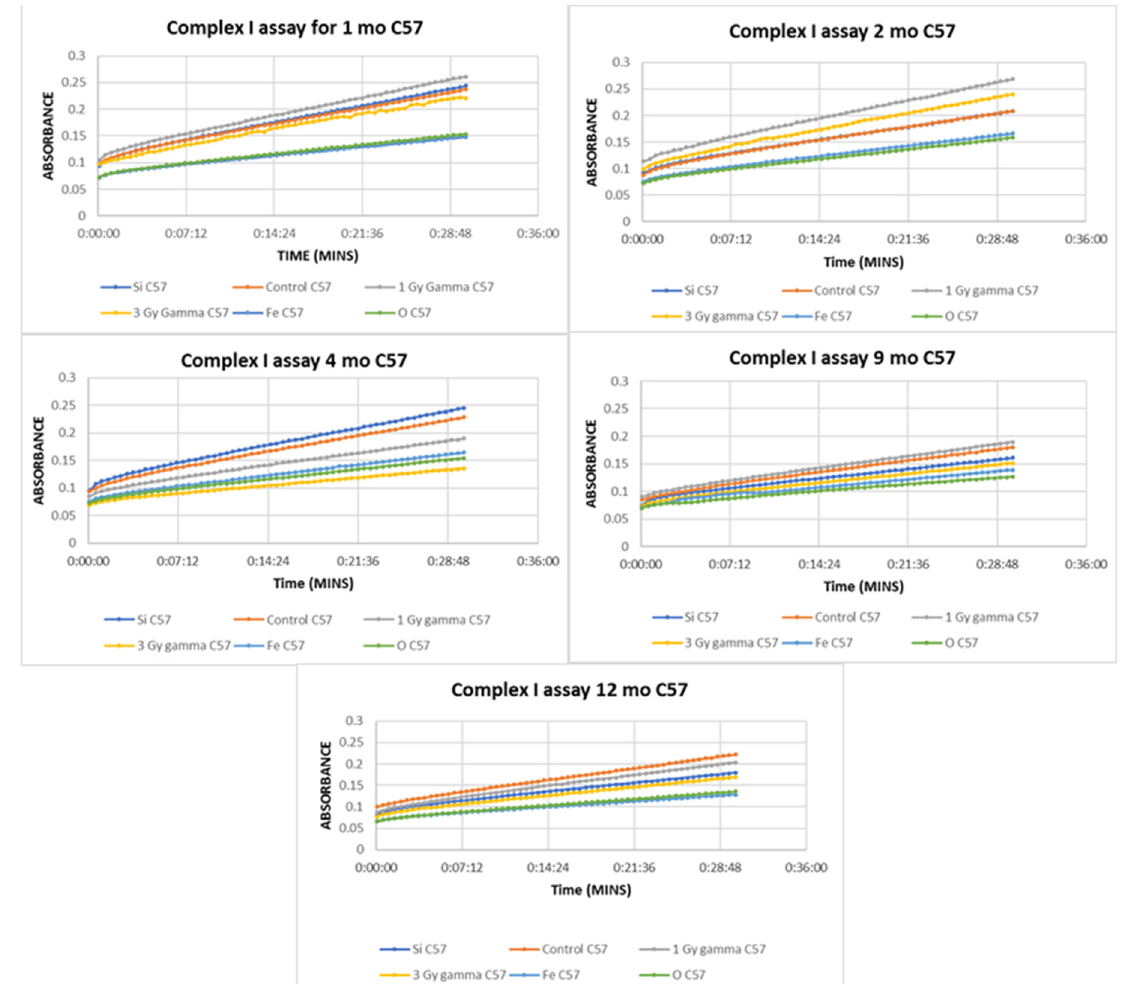
Figure 3. Mitochondrial Complex I activity of C57BL/6 mice at 1 month post-irradiation exhibited a decrease in 16 O- and 56 Fe-irradiated mice livers as compared with the non-irradiated control. All slopes are significantly different ( p < 0.0001) except for 28 Si and non-irradiated ( p = 0.5600) as well as 56 Fe and 16 O ( p = 0.3964). At 2 months post-irradiation, similar decreases in 16 O- and 56 Fe-irradiated mice livers were observed as compared with the non-irradiated control. All slopes are significantly different ( p = 0.0005 for 56 Fe and 16 O and p < 0.0001 for all others) except for 28 Si- and non-irradiated ( p = 0.9981) mice livers. At 4 months post-irradiation, a decrease was seen in 16 O, 56 Fe, 1 Gy gamma, and 3 Gy gamma as compared with the non-irradiated control. All slopes are significantly different ( p < 0.0001). At 9 months post irradiation, a decrease was seen in all irradiation types as compared with the non-irradiated control except for 1 Gy gamma. All slopes are significantly different ( p < 0.0001). At 12 months post-irradiation, a decrease was seen in all irradiation types as compared with the non-irradiated control. All slopes are significantly different ( p = 0.0158 for 56 Fe and 16 O and p < 0.0001 for all others). All data points represent a group of n = 3 and correlate to the same animals from which the transcriptomic and proteomic data were generated.